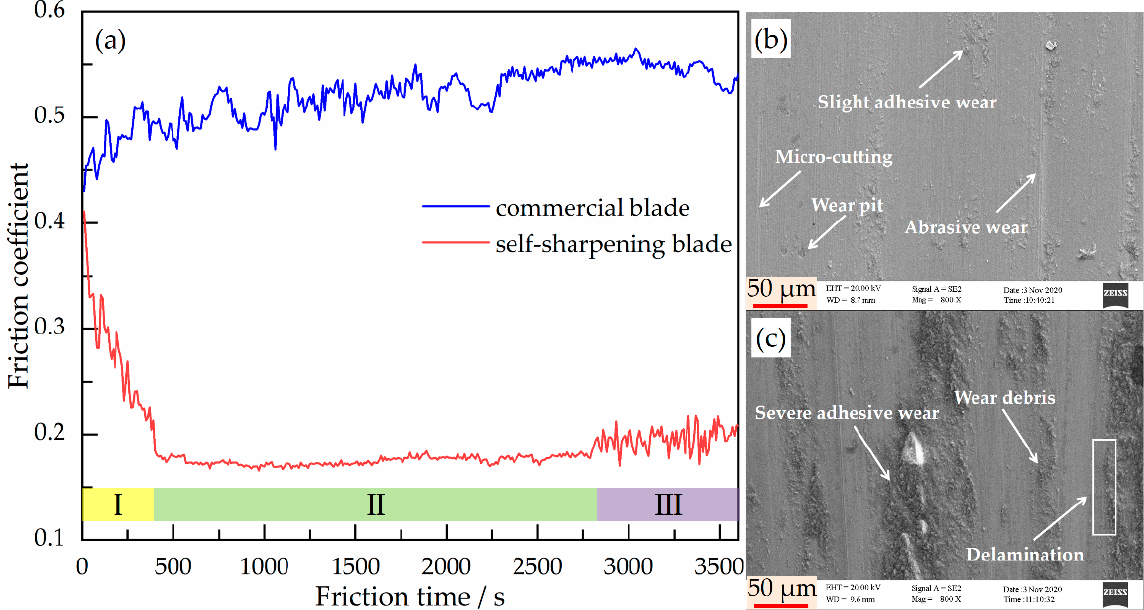
Figure 3. Friction coefficient curve and wear morphology: ( a ) friction coefficient curves of different blade materials; ( b ) wear morphology of self-sharpening blade materials; ( c ) wear morphology of commercial blade materials.